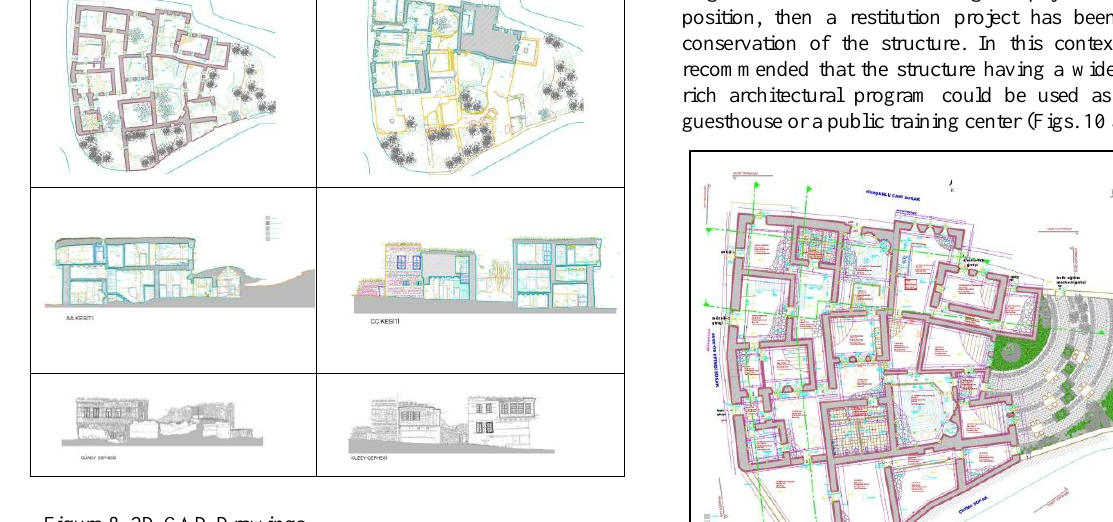
Figure 8. 2D CAD Drawings